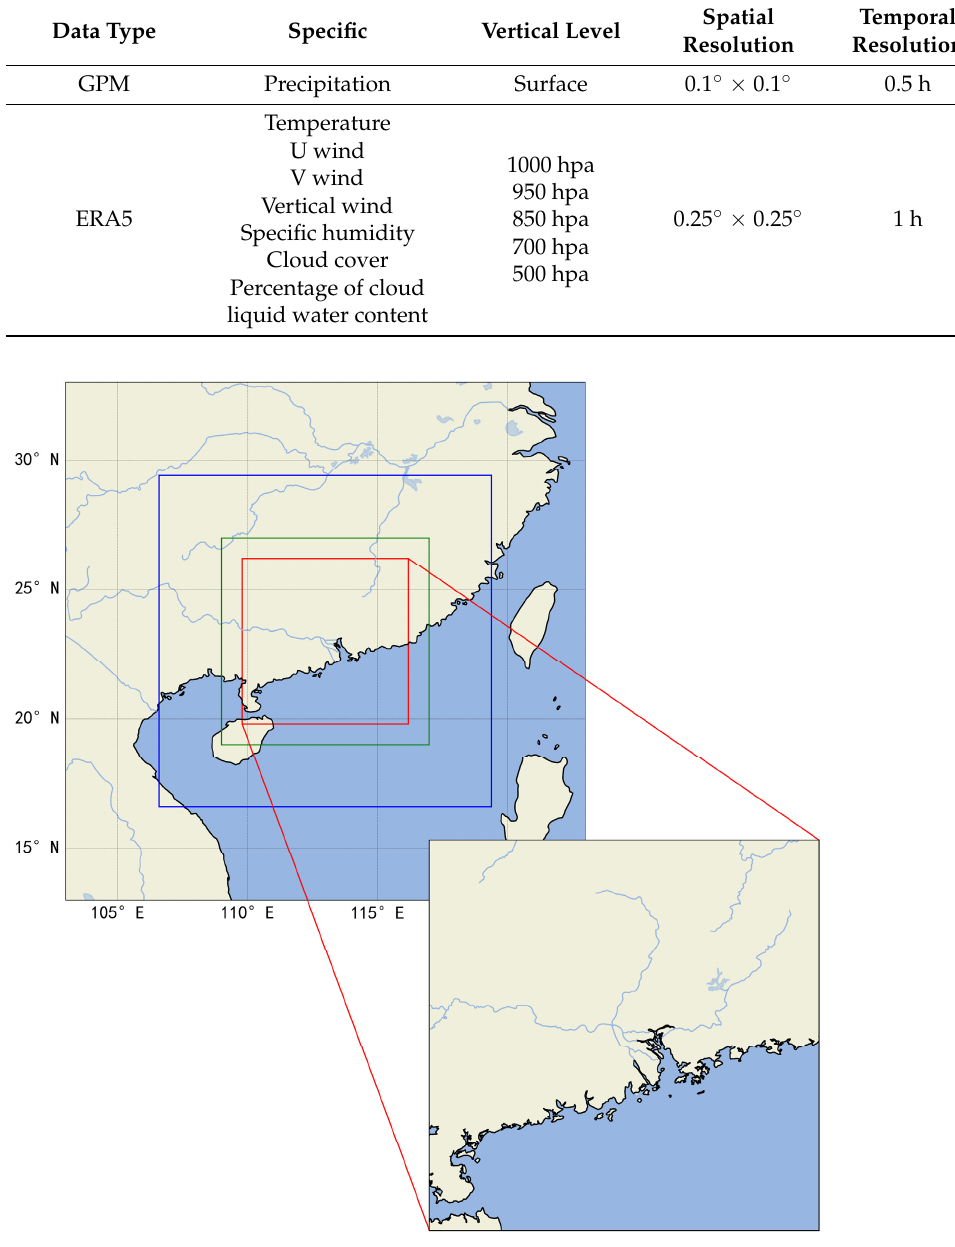
Figure 1. Visualization of the study area . The red box is the research area of this paper, the blue box is the large-scale GPM precipitation data input area, and the green box is the ERA5 multi- meteorological factor data input area. factor data input